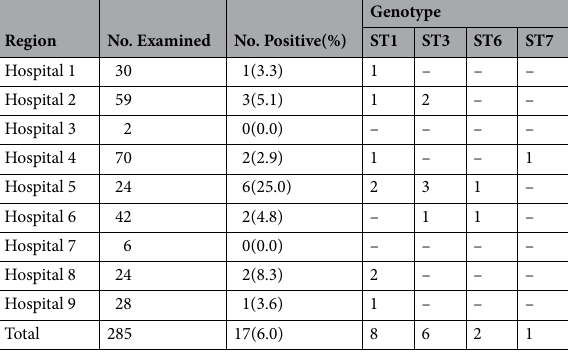
Table 2. Genotype distribution of B. hominis in the present